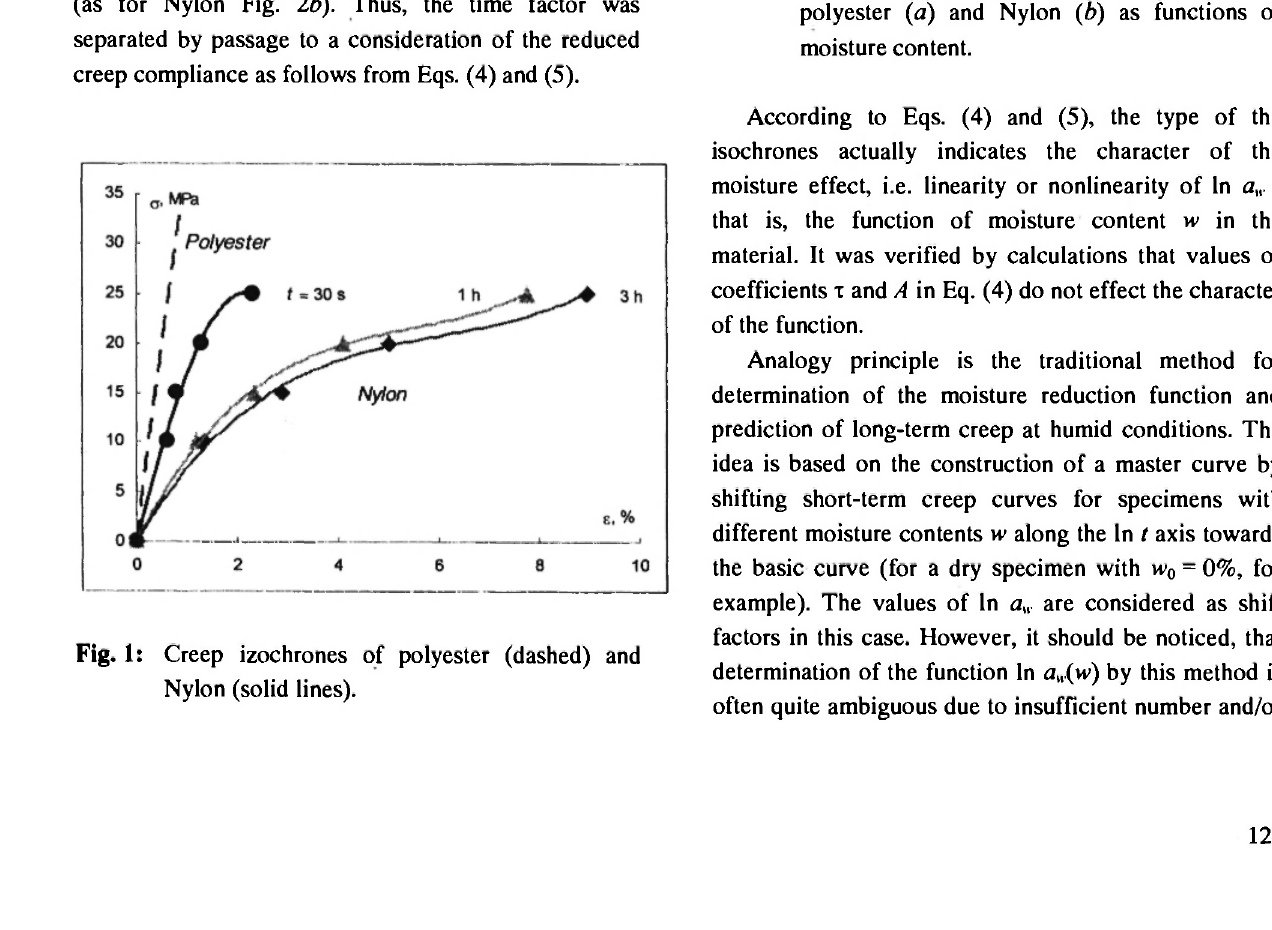
Fig. 1: Creep izochrones of polyester (dashed) and Nylon (solid lines).